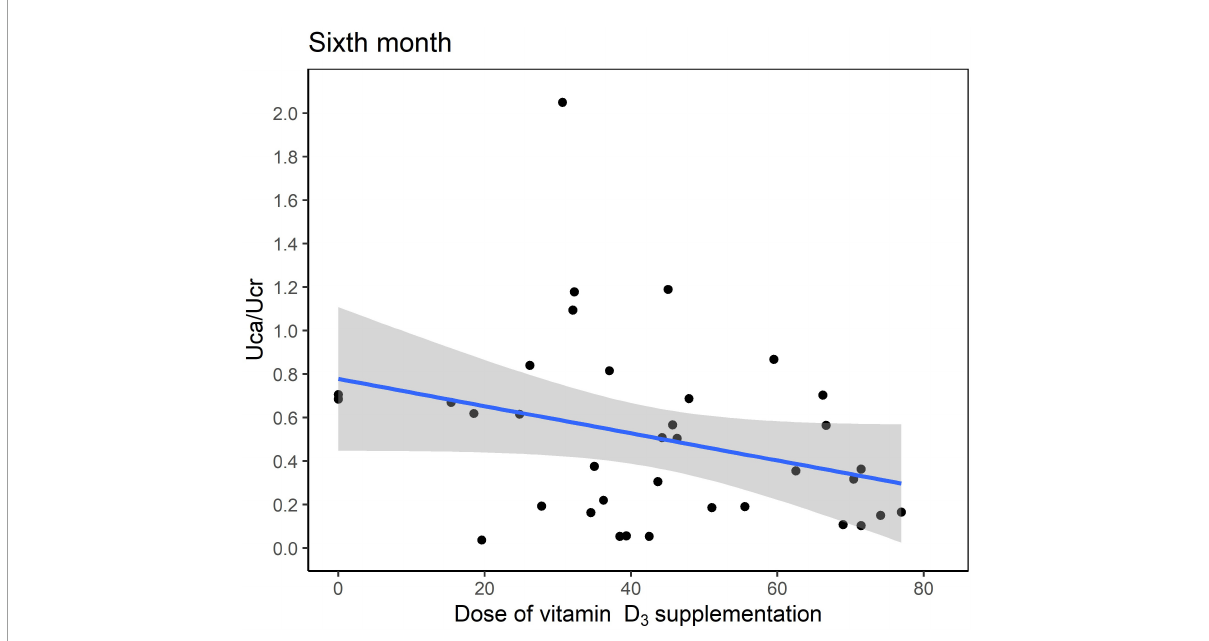
FIGURE2 Scatter plot between the urinary excretion of calcium (Uca) to urinary excretion of creatinine (Ucr) ratio and dose of vitamin D 3 supplementation at 6 months after ketogenic dietary therapy initiation.